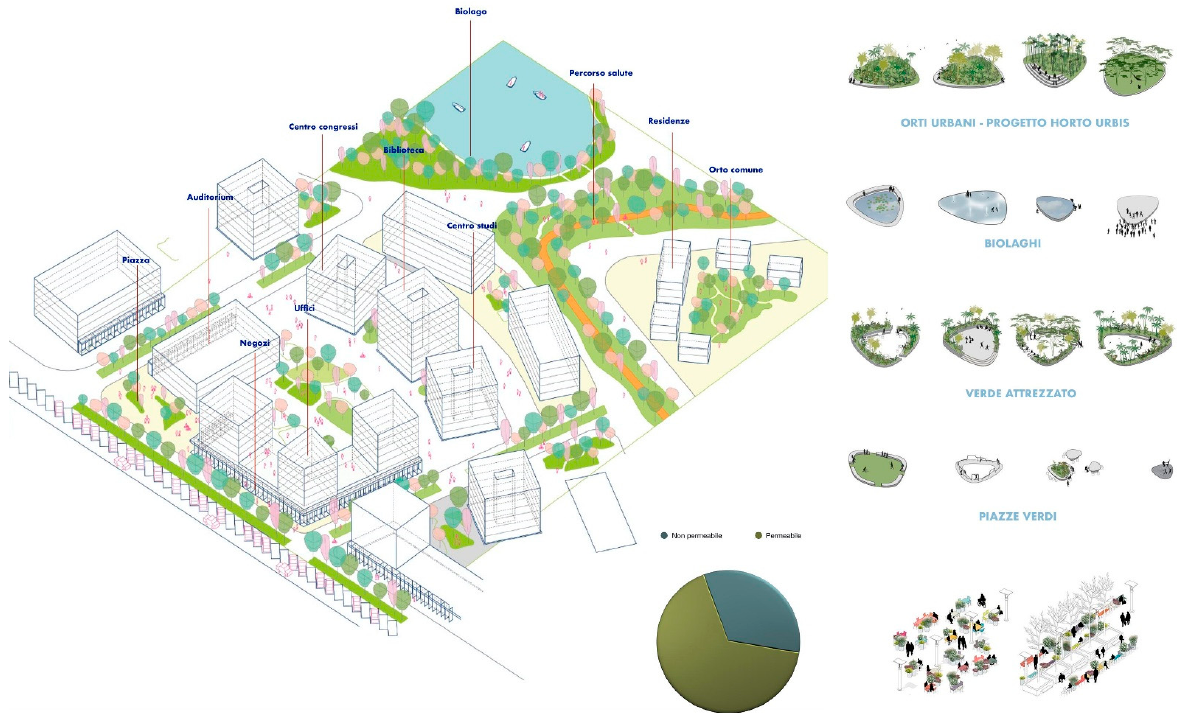
Figure 7. Rome Municipality X, Urban and Metropolitan Centrality Acilia–Madonnetta. Urban project. Volumetric plan of an urban sector. (Source: elaborations by the students: S. Maiorano, F. J.